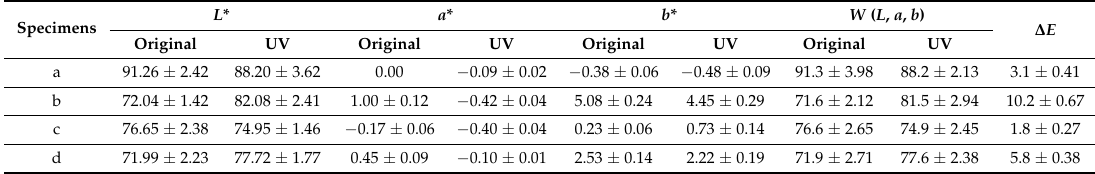
Table 2. Anti-discoloration test of ion-exchanged